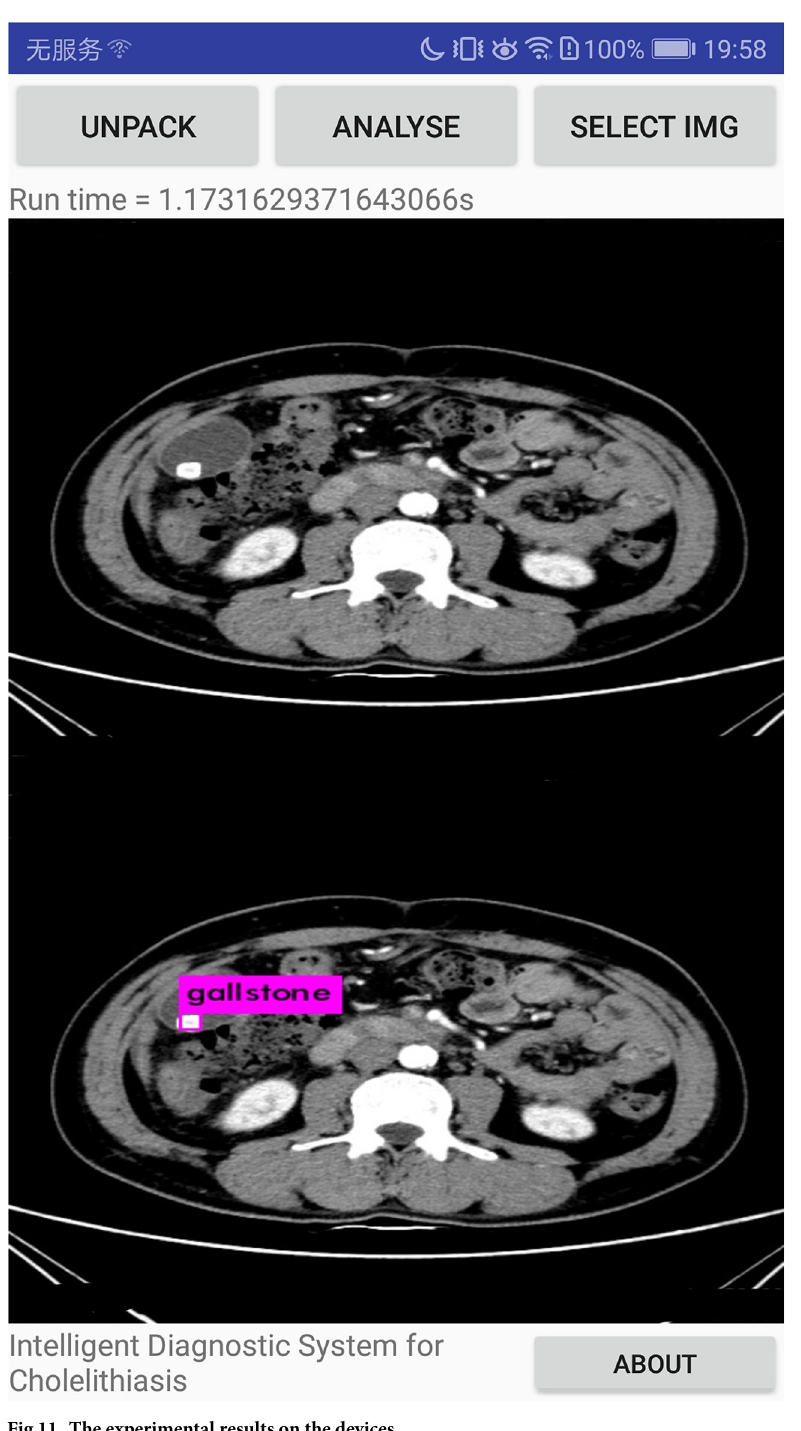
Fig 11. The experimental results on the